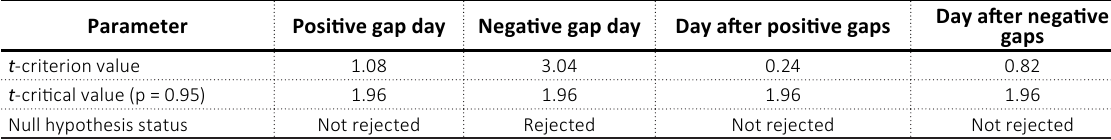
Table A2. T -test, the case of the UX index over the period